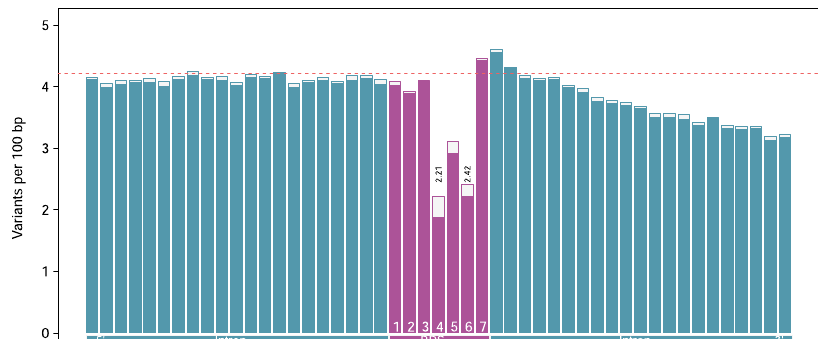
Fig. 6 Local variation at the human branch point sequence (BPS). The height of the bars indicates the variation (variants per 100 bp) surrounding 201,832 branch points while the solid bars indicate the variation surrounding a subset of 184,468 branch points encompassed by a heptamer with a canonical ( “ TNA ” ) motif. The dotted horizontal red line indicates the average genome-wide compared to intronic adenine (1.97) and thymine (1.94) residues